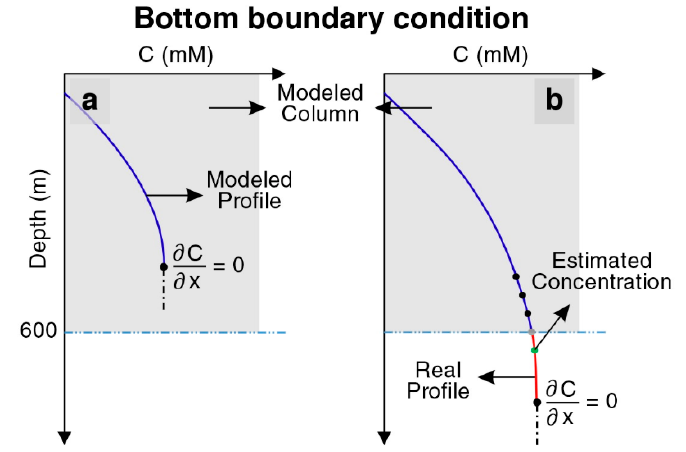
Figure 2. Graphics illustrating the approach to define bottom boundary conditions for methane, DIC, and free gas. ( a ) Zero concentration gradient is imposed before the first layer of the sediment reaches the bottom of the model at a depth of 600 m. ( b ) Extrapolating a virtual point after the first layer passes the bottom of the